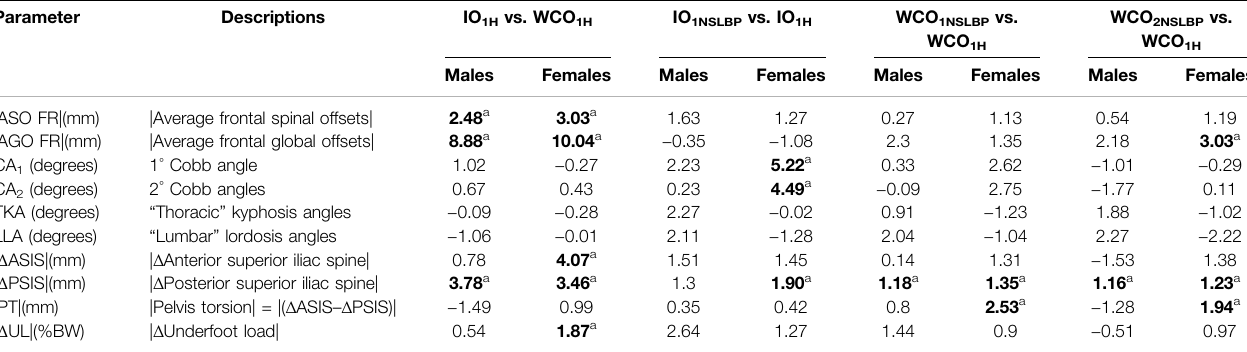
TABLE 6 | NSLBP patients vs. healthy young adults subdivided by gender for the following comparisons: IO 1H vs. WCO 1H , IO 1NSLBP vs. IO 1H , WCO 1NSBLP vs. WCO 1H, and WCO 2NSBLP vs. WCO 1H